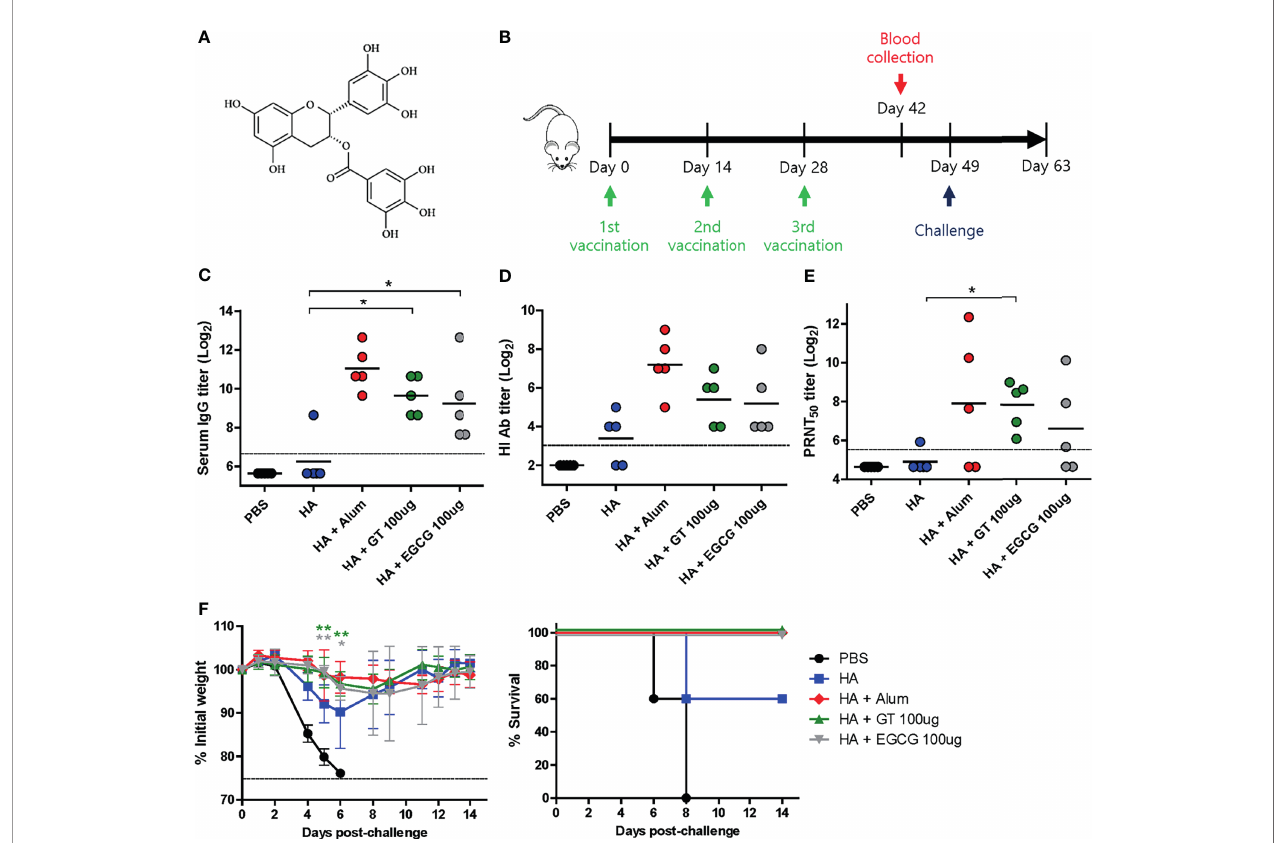
FIGURE 1 | Adjuvant effects of GT or EGCG in combination with HA antigen. PBS or 4 m g of HA antigens (recombinant, full-length) with or without adjuvant (alum 50 m L, GT 100 m g, or EGCG 100 m g) were injected into mice via IM route thrice every 2 weeks. The vaccinated mice were challenged with 2 × 10 3 PFU (2 MLD 50 ) of wild type PR8 virus 3 weeks after the last vaccination. (A) Chemical structure of EGCG. (B) Vaccination, blood collection, and challenge schedule. (C) IgG antibody response to in fl uenza PR8 virus. The antibody titer of each sample was expressed as the endpoint dilution with an absorbance value 2× greater than that of the PBS control group. The detection limit (dashed line) was 100. (D, E) Neutralizing antibody responses to in fl uenza PR8 virus. HI antibody titers (D) and PRNT 50 titers (E) against the PR8 virus are shown. The detection limits of HI assay and PRNT (dashed lines) were 8 and 50, respectively. (F) Protective ef fi cacy against in fl uenza PR8 virus. The changes in weight and survival rates of the mice were monitored. Dashed line indicates humane endpoint which means losing 25% weight loss. Mice that lost >25% body weight were euthanized. Data of antibody titers (C – E) were log-transformed and expressed as means (horizontal lines) and scatter plots. Data of the changes in weight ( F , left panel) are shown as means (points) and standard deviations (error bars). One-way ANOVA followed by Tukey ’ s multiple comparison test was conducted to compare three or more groups. Repeated measures two-way ANOVA followed by Bonferroni ’ s post-test was used to analyze weight changes for different mouse groups over time. Each group was compared with the group given the non-adjuvanted HA (** P < 0.01; * P <